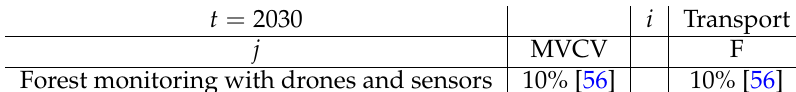
Table 15. Smart Land use